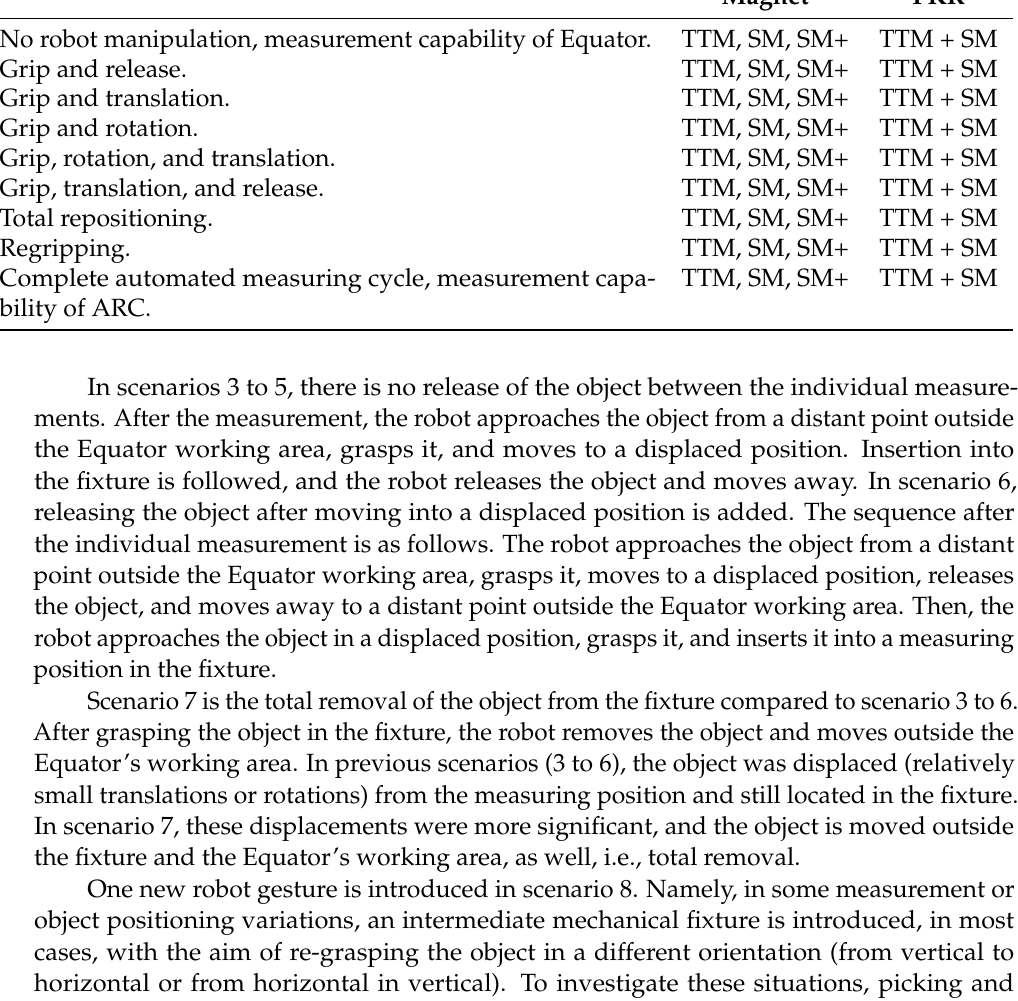
Table 1. Short description of nine robotized scenarios for an investigation of the robot’s influence on the capability of the measurement process C p with used measurement methods in Equator gauge. For the Magnet object, three different measurement methods were used (touch-triggering method (TTM), scanning method (SM), and scanning method with additionally increased sampling points (SM+)); for the PKR object, only a combination of TTM and SM was used. Measurement Scenario Description of Scenario Scenario